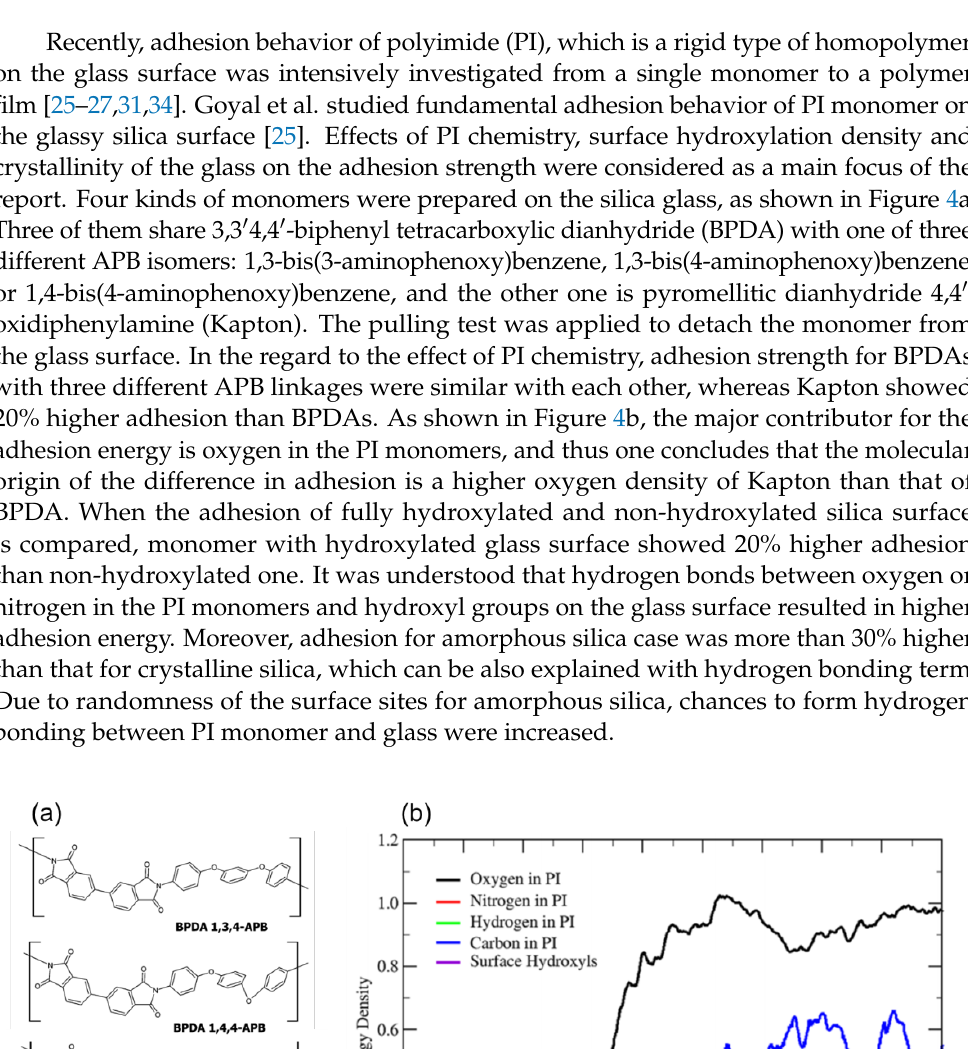
Figure 5. ( a ) Snapshots for deformation of polyimide chain: DHBZ–BPDA (left) and DHBZ–DPDA (right). ( b ) Decompo- sition of energy terms and their evolution as a function of pulling distance (reprinted from Reference [26], Copyright 2016, with permission from Elsevier). The result shows that, for both DTDA and BPDA, intramolecular energy from C–C bonds in the chain initially increases at the early stage of pulling, but readily reduces to